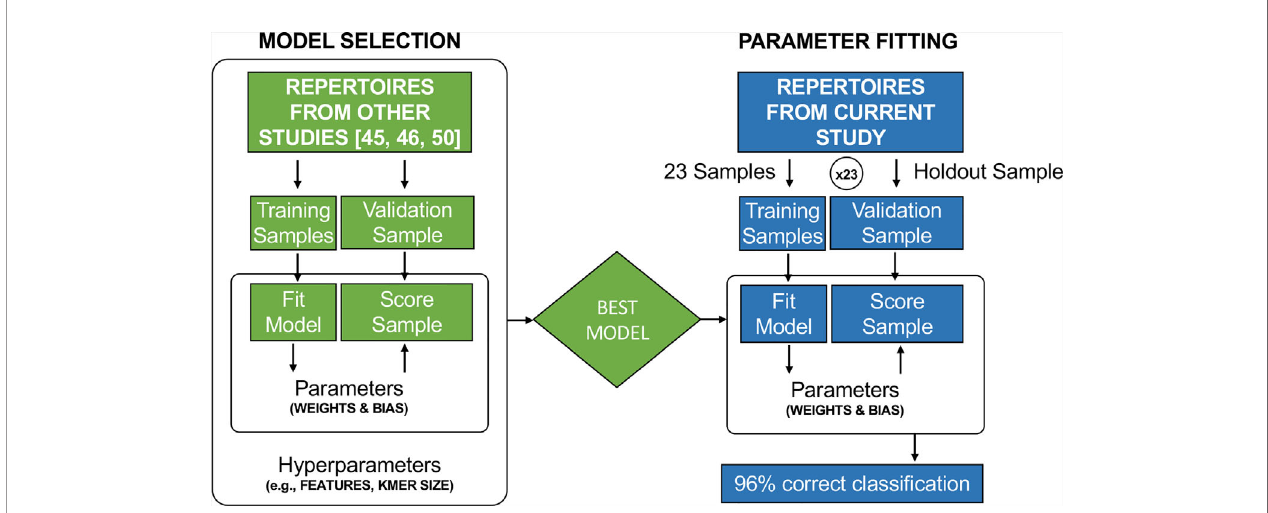
FIGURE 2 | Model selection was conducted in earlier studies (45, 46, 50) to determine the best representation of TCR CDR3 sequences, such as the best k-mer size and the use of Atchley Factors rather than a DNA or AA sequence representation. The cervical cytology samples used in this study were not included in the model selection process. In this study, the previously identi fi ed best model was used, and the weights and bias term were fi t by gradient descent in leave-on-out